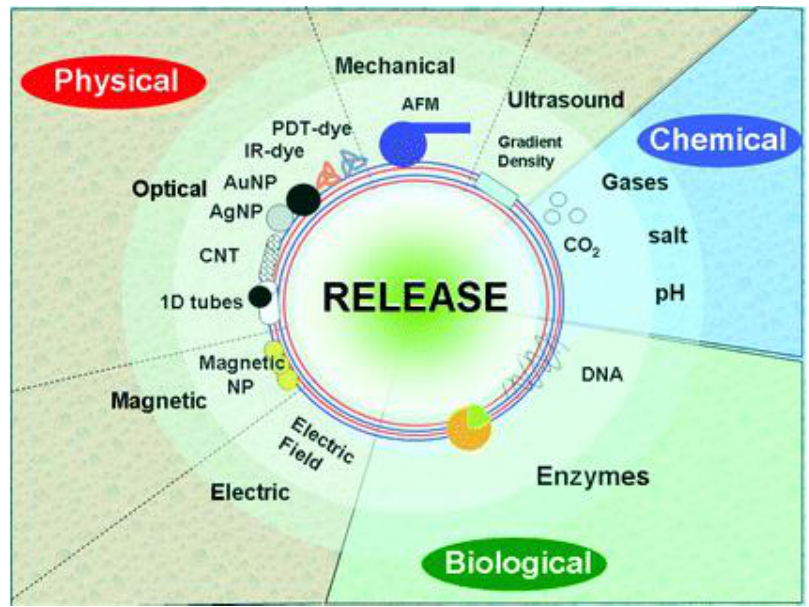
Figure 3. Scheme showing the different types of stimuli for release of encapsulated compounds from LbL materials. Reproduced from [31], with permission from The Royal Society of Chemistry. LbL materials. Reproduced from [31], with permission from The Royal Society of